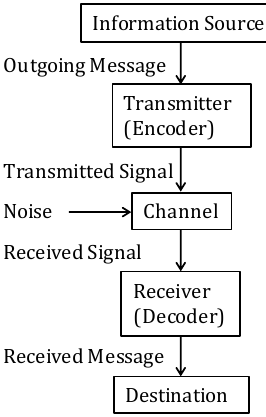
Figure 1: Schematic diagram of a general communication system, as described by Shannon in